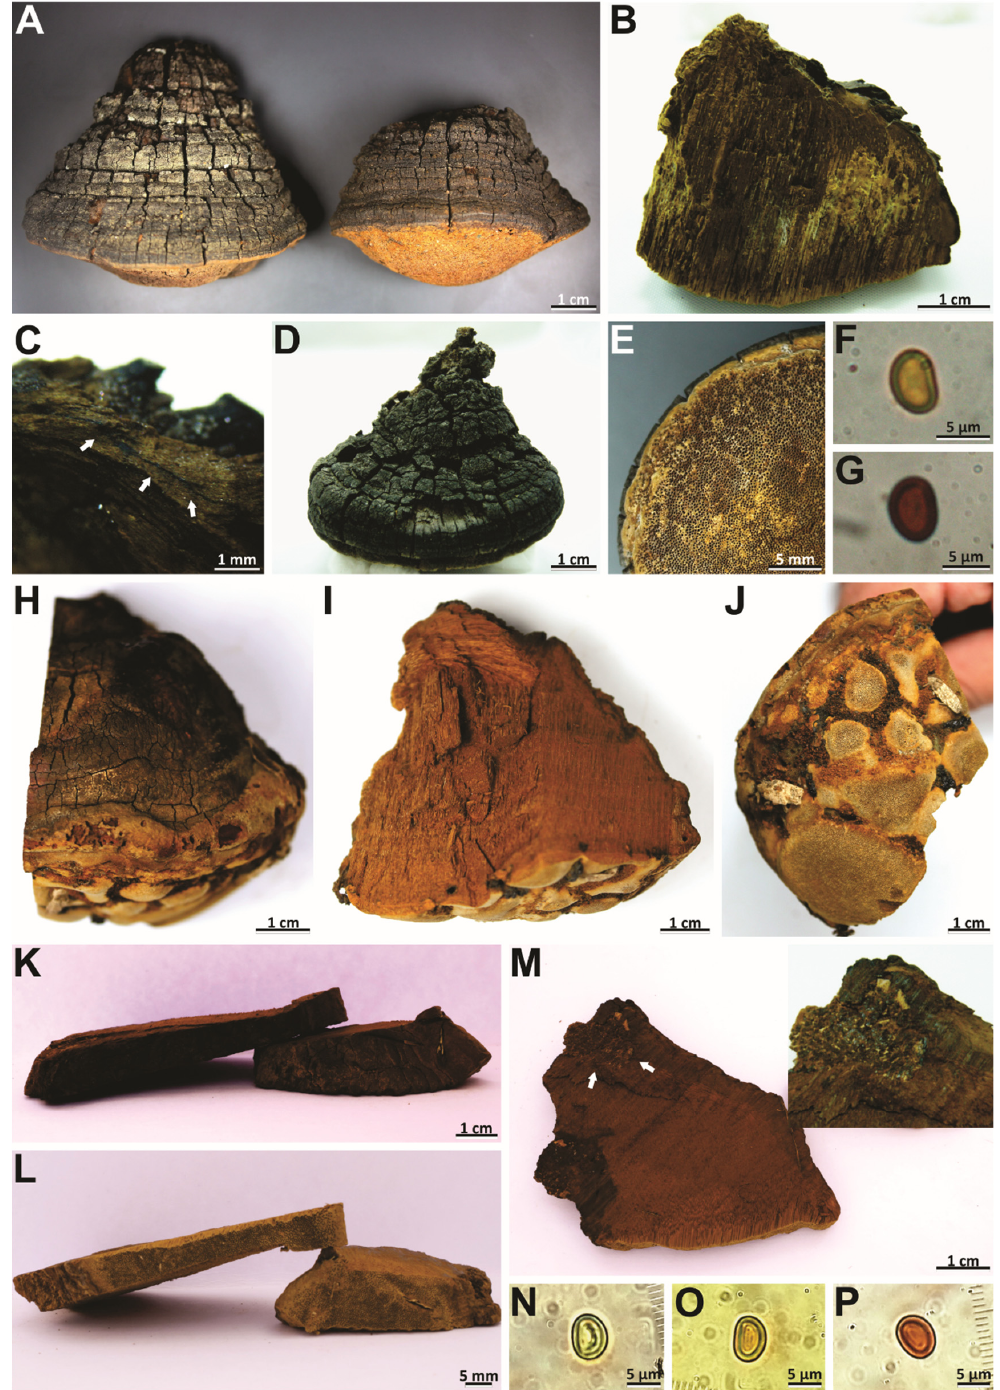
Figure 8. Morphological features of Phellinotus resinaceus and P . xerophyticus . ( A – G ) Phellinotus xerophyticus . ( A – C ) CORD 3552. ( A ) basidioma with rimose pileal surface; ( B , C ) perennial basidioma with a dark line in the context; ( D – G ) CORD 3551: ( D ) basidioma with rimose pileal surface; ( E ) pore surface; ( F , G ) basidiospores. ( F ) in water; ( G ) in KOH. ( H – P ) Phellinotus resinaceus . ( H – J ) K–M: 180663 (holotype); ( H – I ) perennial basidioma with cracked pileal surface; ( J ) pore surface; ( K – M ) PRM 671088 (paratype). ( K ) Cracked pileal surface; ( L ) pore surface; ( M ) perennial basidioma with detail of mycelial core in the context. ( N – P ) Basidiospores ( K – M : 180663, holotype). ( N ) In the water; ( O ) in Melzer’s reagent, ( P ) in